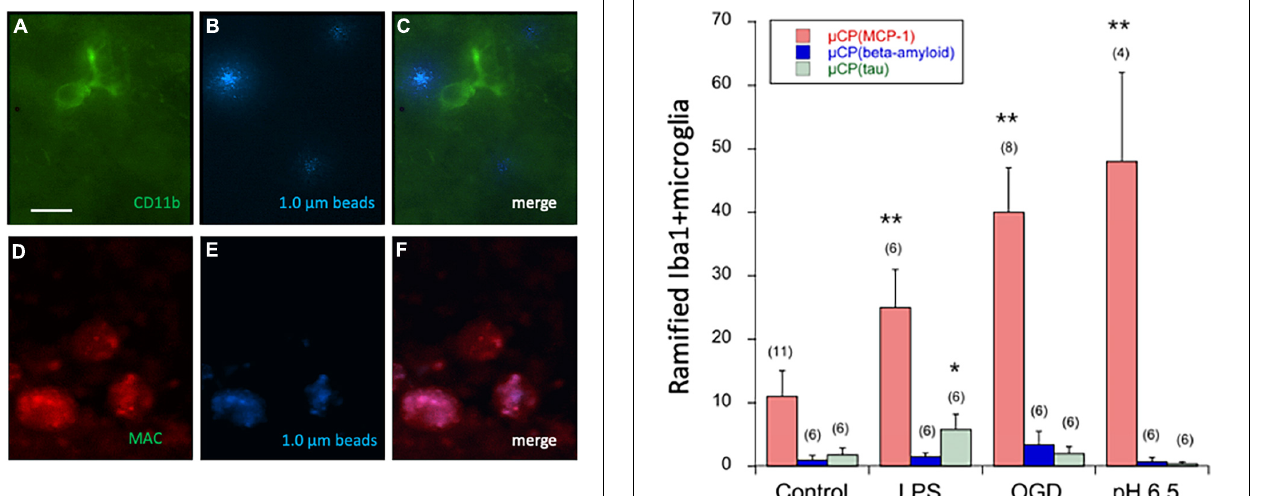
FIGURE 5 | Immunostaining for CD11b, macrophage-like antigen (MAC) and phagocytosed 1.0 µ m blue fluorescent beads on microcontact prints loaded with MCP-1. Ramified CD11b [green Alexa-488; (A) ] and activated phagocytic microglia (red, Alexa-546, D ) were found. Blue fluorescent beads (B,E) were phagocytosed by activated phagocytic microglia (F) but not ramified microglia (C) . Scale bar in panel (A) = 35 µ m (A–F) . ramified microglia ( Figure 5C ). In average 8.7 ± 3.4 ( n = 6) CD11b + microglia and 5.5 ± 2 ( n = 6) activated phagocytic microglia per 300 µ m field were counted in controls, which was not different to OGD treatments.